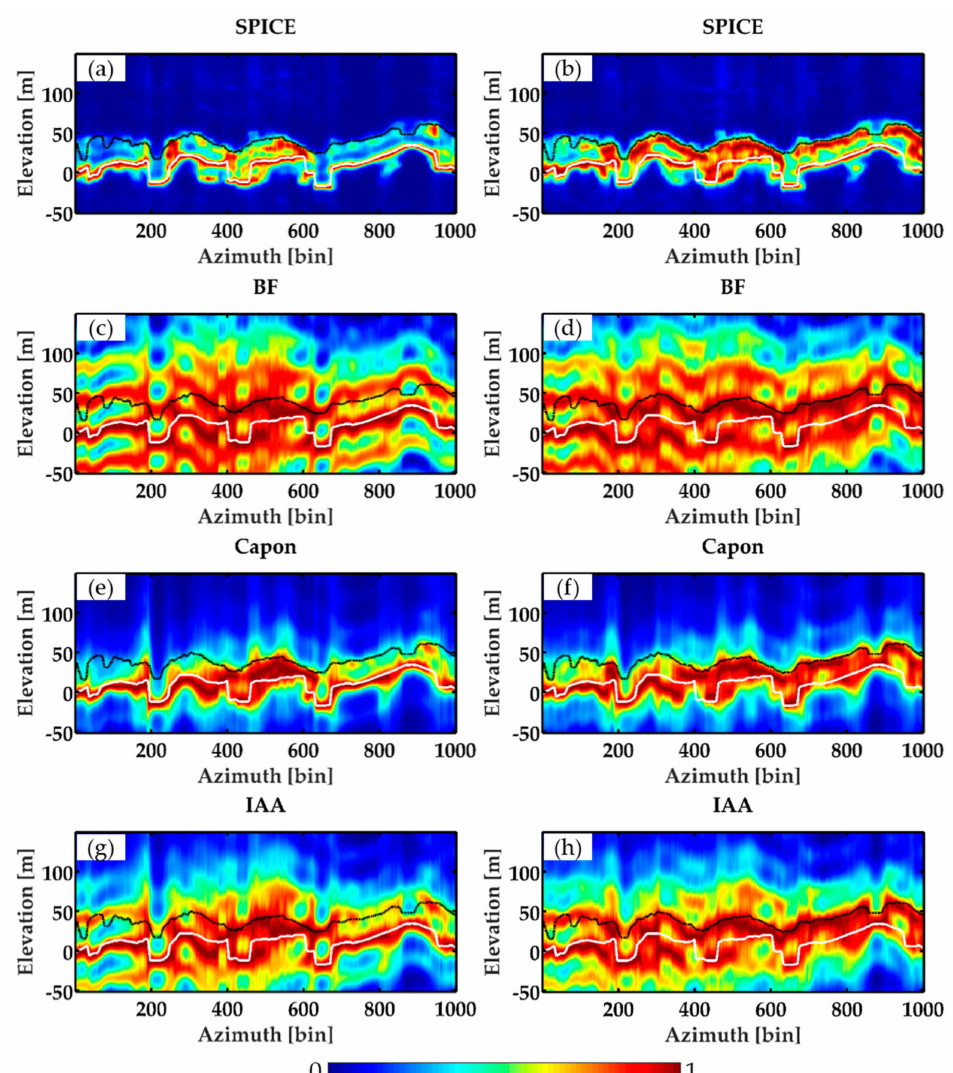
Figure 11. Tomograms estimated by the three tomographic algorithms in two polarimetric channels: ( a) W&O-SPICE in the HH polarization; ( b ) W&O-SPICE in the HV polarization; ( c ) beamforming in the HH polarization; ( d ) beamforming in the HV polarization; ( e ) Capon in the HH polarization; ( f ) Capon in the HV polarization; ( g ) IAA in the HH polarization; ( h ) IAA in the HV polarization. The solid black line represents the LiDAR CHM, and the solid white line represents the LiDAR